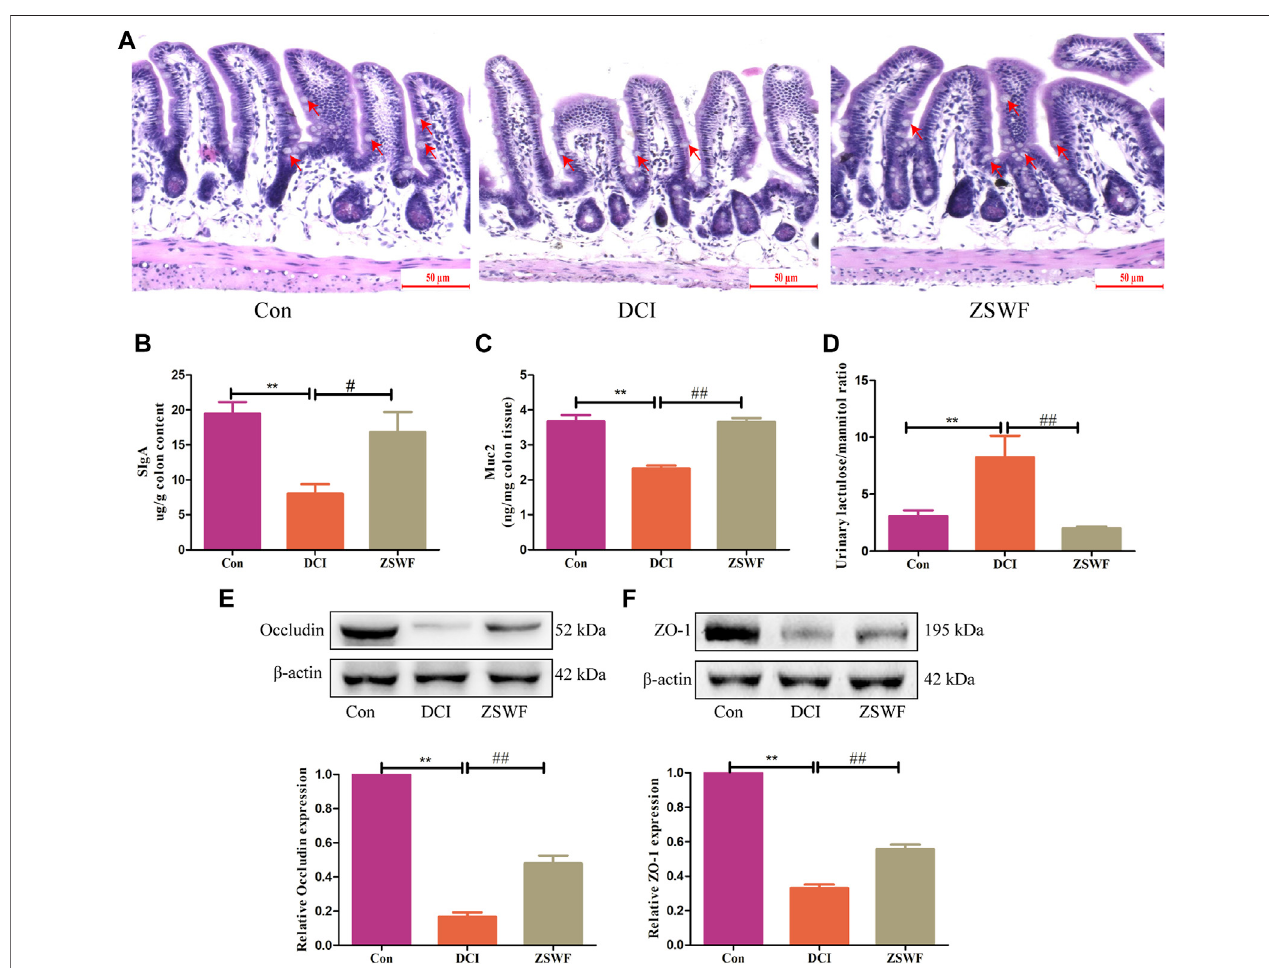
FIGURE 3 | ZSWF maintains intestinal integrity in DCI mice. (A) representative images of colon HE staining, the goblet cells marked by the red arrow, scale bar 50 μ m ( n = 3). (B,C) SlgA and Muc2 contents in the colon, (D) lactulose to mannitol ratio, these data were expressed as mean ± SD ( n = 5). (E,F) occludin and ZO-1 representedWesternblottingbandsandrelativeproteinexpressionlevelsinthecolon,datawereexpressed asmean±SD( n =3).Alldatawereanalyzedusingone-way ANOVA, ** p < 0.01 vs. Con group, ## p < 0.01, # p < 0.05 vs. DCI group.